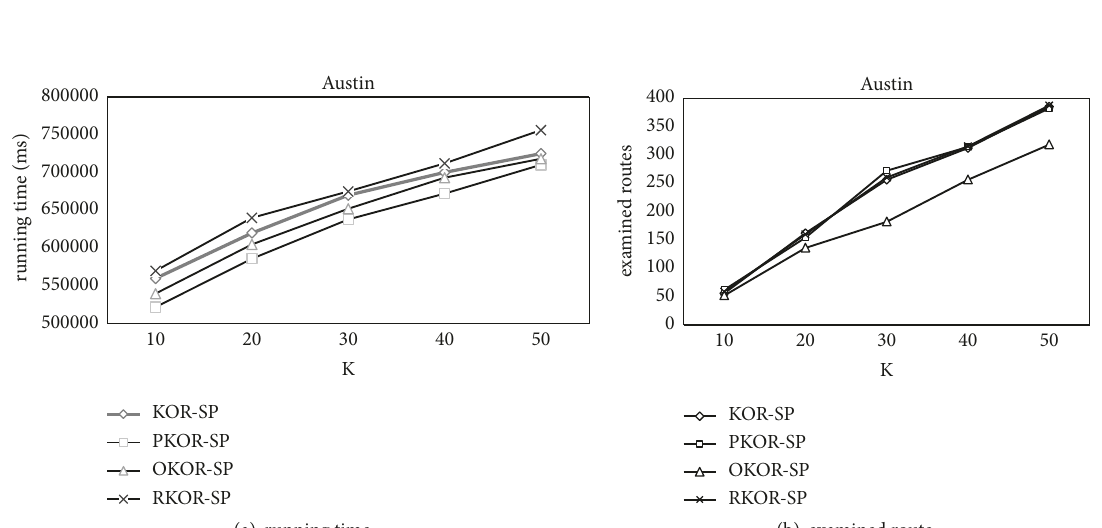
Figure 11: Effect of 𝛽 .